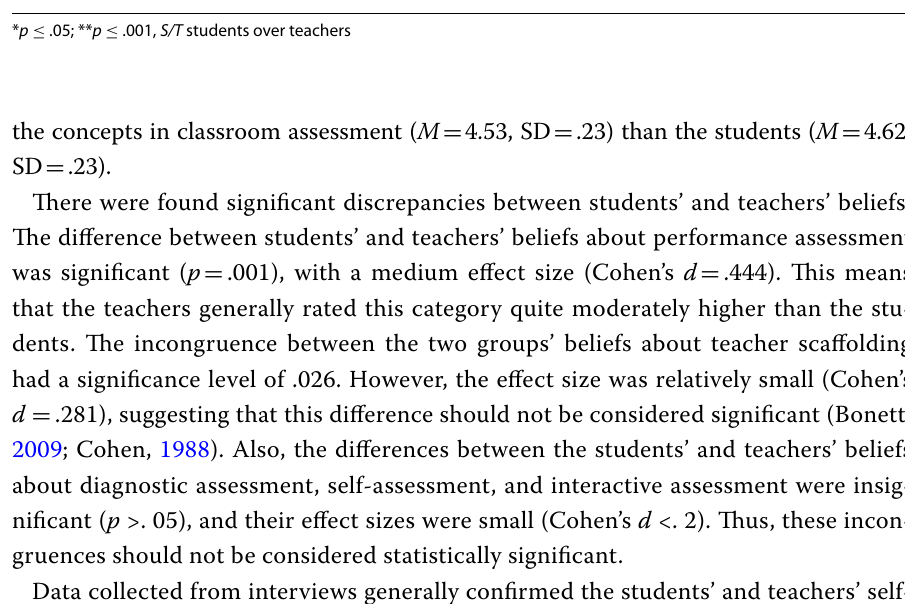
* p .05; ** p .001, S/T students over ≤ ≤